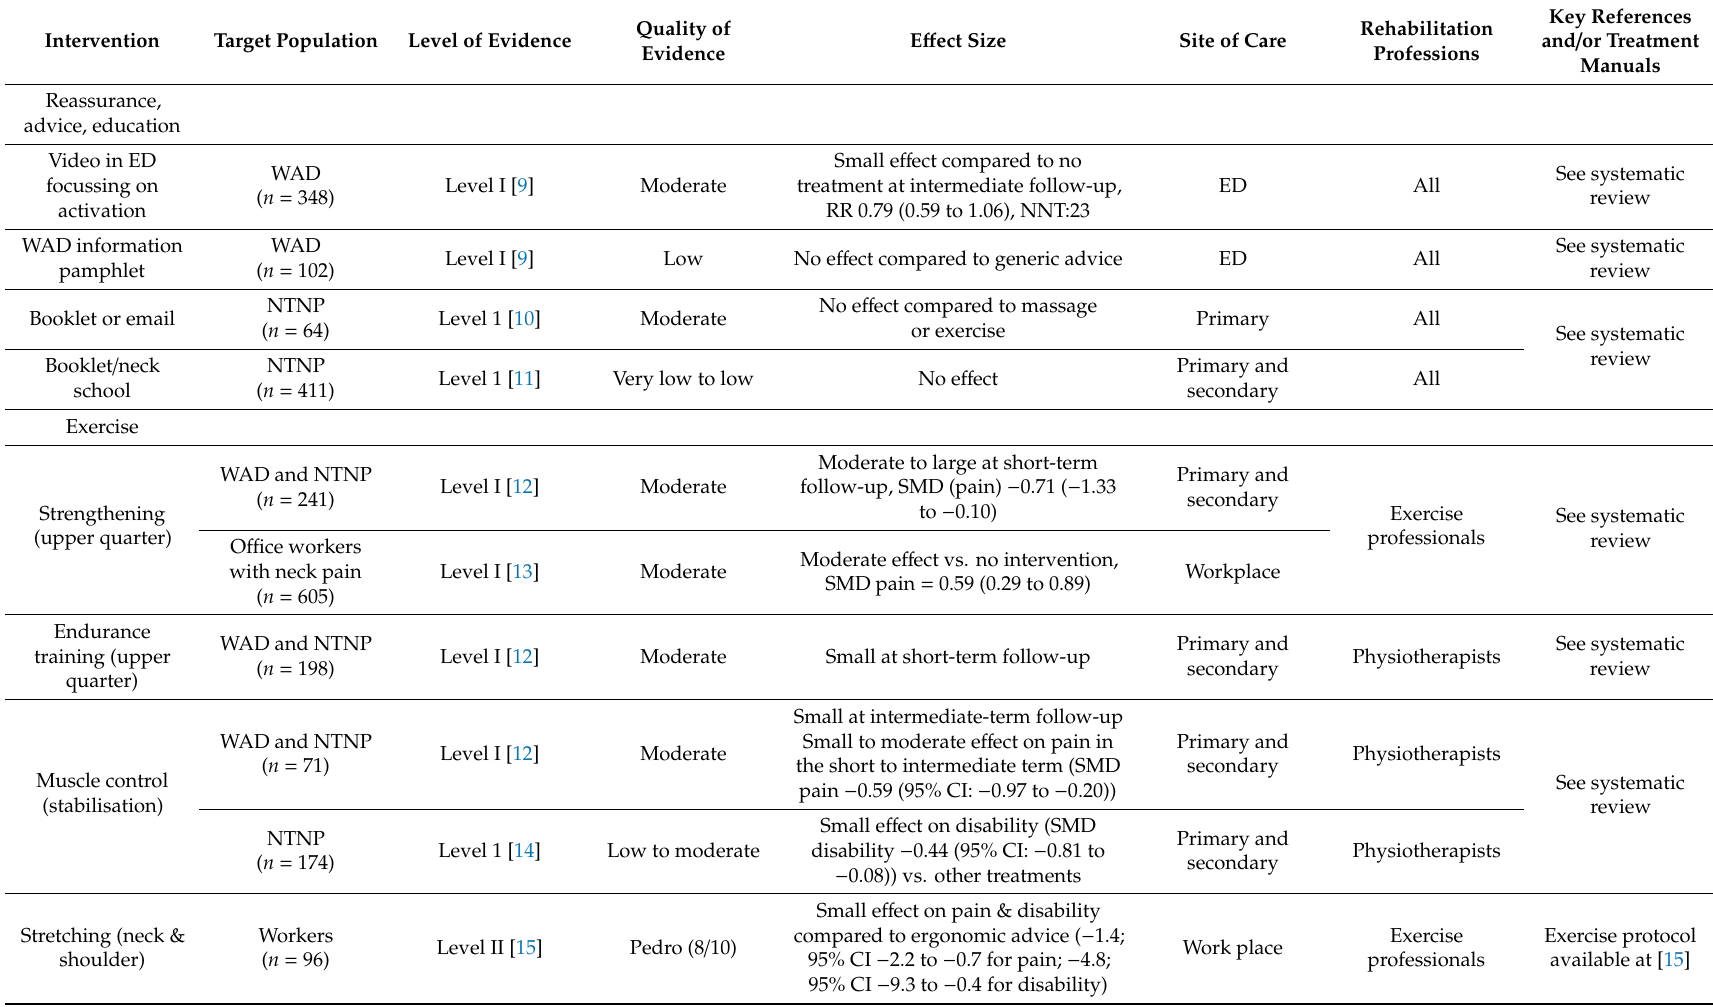
Table 1. Best evidence summary—systematic reviews and RCTs if conducted after publication of a relevant systematic